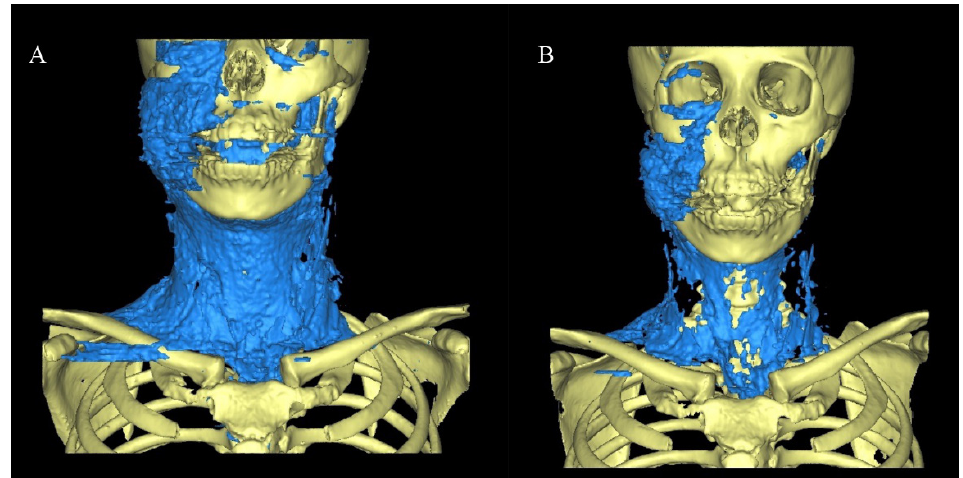
Figure 6. ( A ) 3D model based on the CT taken at the first visit. The volume was measured to be about 713 mL. ( B ) 3D model on the 3rd day after injury. The volume was measured to be about 248 mL.